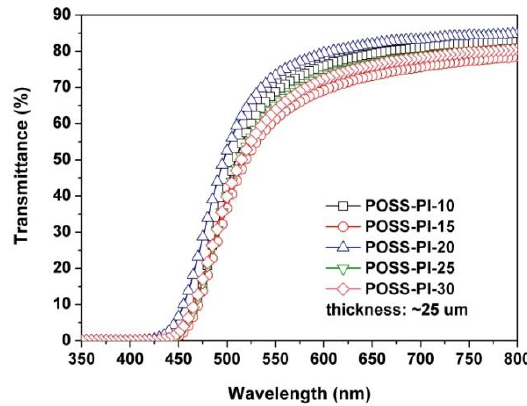
Figure 6. UV-Vis spectra of POSS-PI composite films.